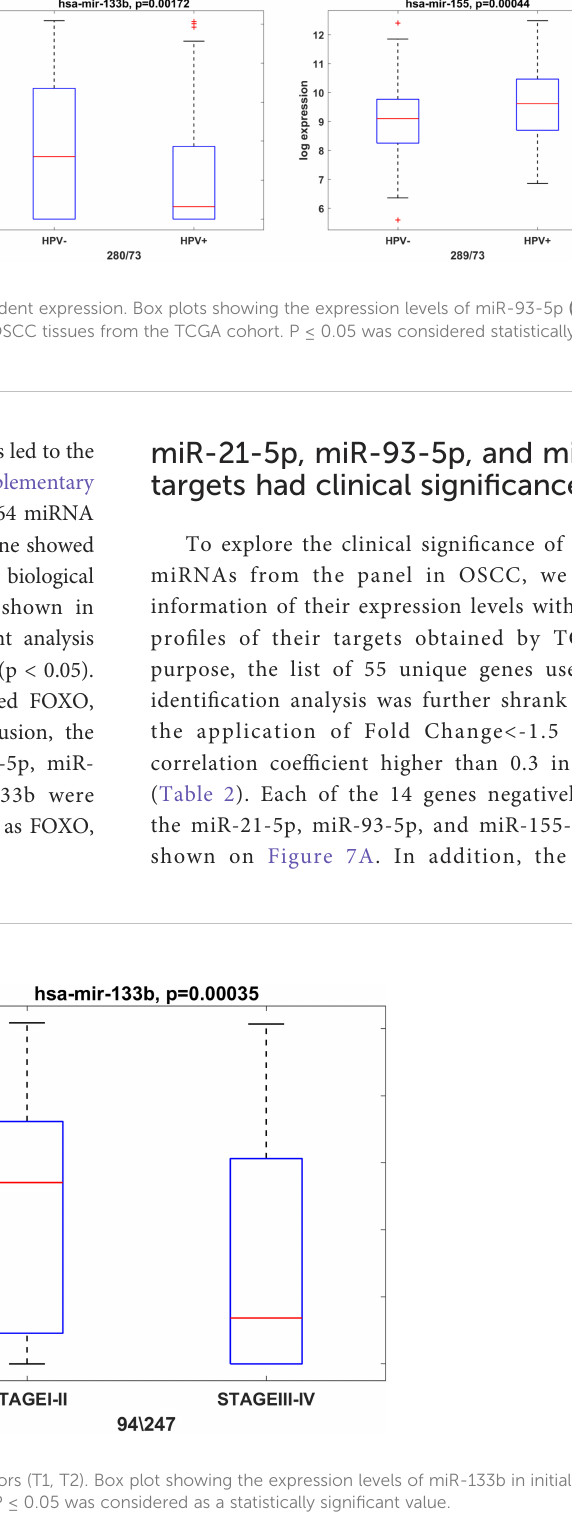
FIGURE 4 miR-133b is predominantly expressed in initial stage tumors (T1, T2). Box plot showing the expression levels of miR-133b in initial (T1, T2) and advanced (T3, T4) stage tumors from the TCGA cohort. P ≤ 0.05 was considered as a statistically signi fi cant value.